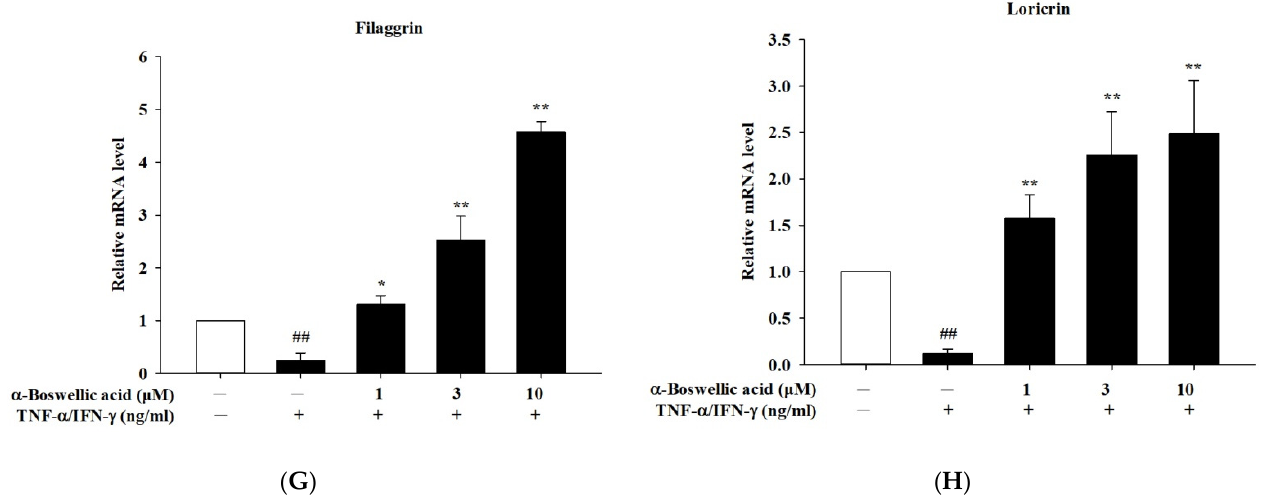
Figure 3. ( A – E ) Effects of α -boswellic acid on the TNF- α /IFN- γ -induced proinflammatory cytokines and chemokine mRNA expressions in HaCaT cells. ( F – H ) Effects of α -boswellic acid on involucrin, filaggrin, and loricrin mRNA expressions in TNF- α /IFN- γ -induced HaCaT cells. HaCaT cells were pretreated with different concentrations of α -boswellic acid—1, 3, and 10 μ M—for 20 min, and then the cells were treated with TNF- α /IFN- γ for 6 h. Total RNA was isolated and the mRNA expression level of IL-1 β , IL-6, IL-8, MDC, TARC, involucrin, filaggrin, and loricrin were determined using qPCR. Values represent the mean ± SEM from three or four independent experiments. ## p < 0.01 compared with the no-treatment condition; * p < 0.05 and ** p < 0.01 compared with the only TNF- α /IFN- γ treatment condition.